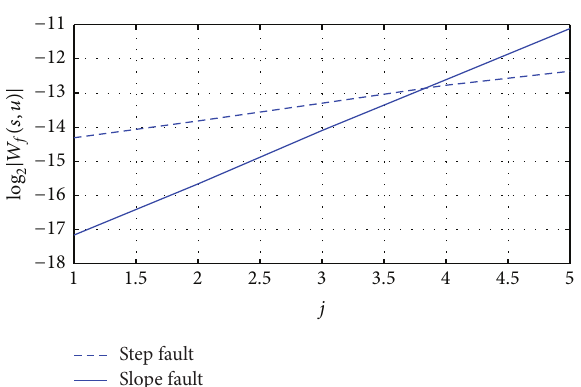
Figure 6: Logarithm curves of modulus maxima at 𝑢 = 100 .